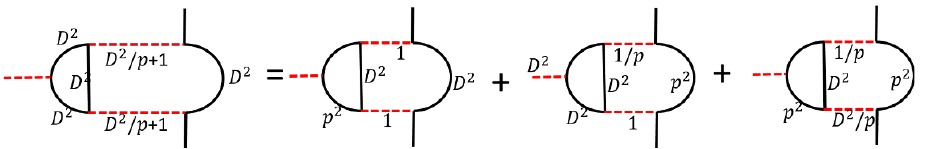
Figure 23. Type ( c ) diagrams.